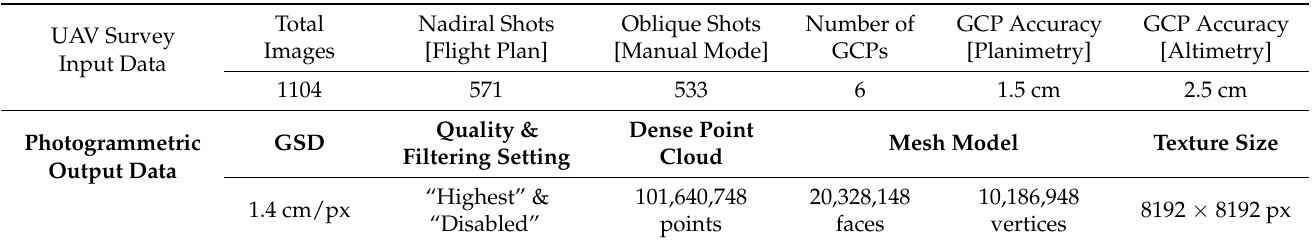
Table 1. For the sake of clarity, the table summarises the input and output data of the photogrammetric survey and subsequent processing. Line 1 and line 3 represent respectively the input and output variables, while lines 2 and 4 contain the numerical values of the said variables for the specific photogrammetric